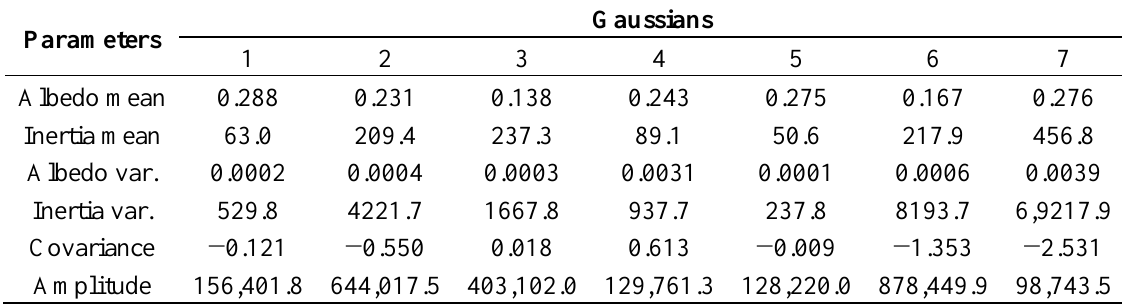
Table 3. Best fit parameters from Gaussian Mixture Model with seven Gaussians.